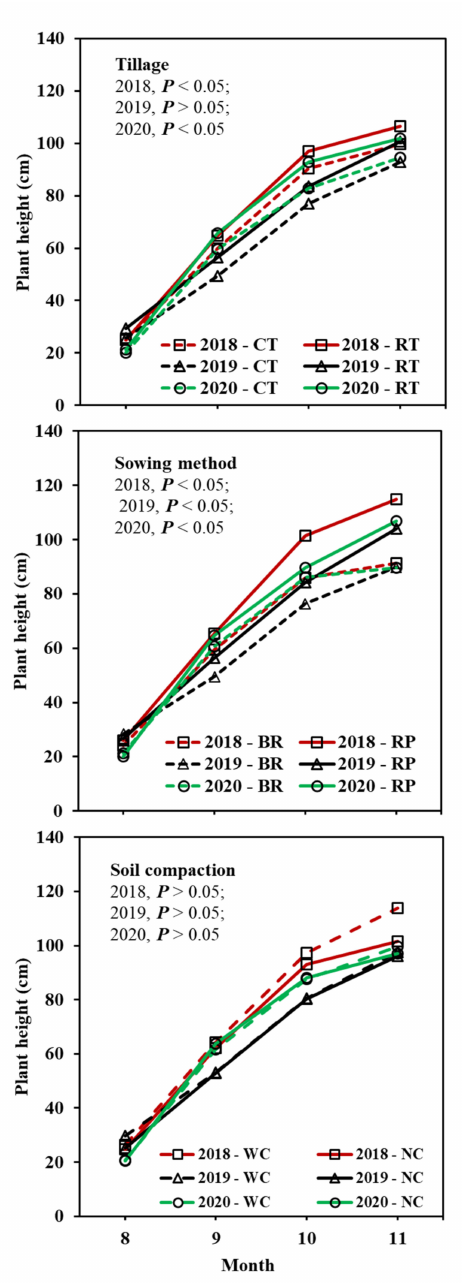
Figure 2. Mean teff plant height throughout the growing months (August to November) obtained with different tillage, sowing, and soil compaction practices. RT, reduced tillage; CT, conventional tillage; RP, row planting; BP, broadcast planting; WC, soil compacted; NC, soil not compacted. Means for plant height at maturity (November) were considered significantly different when P <